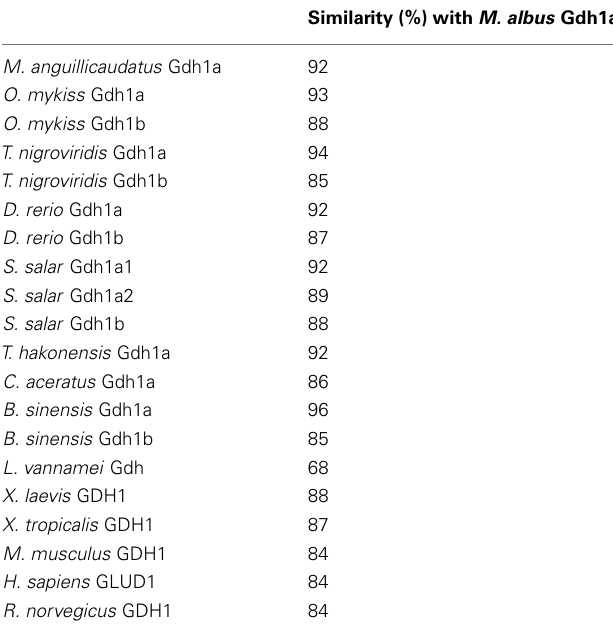
Table 2 | Percentage similarity of GDH/Gdh from various